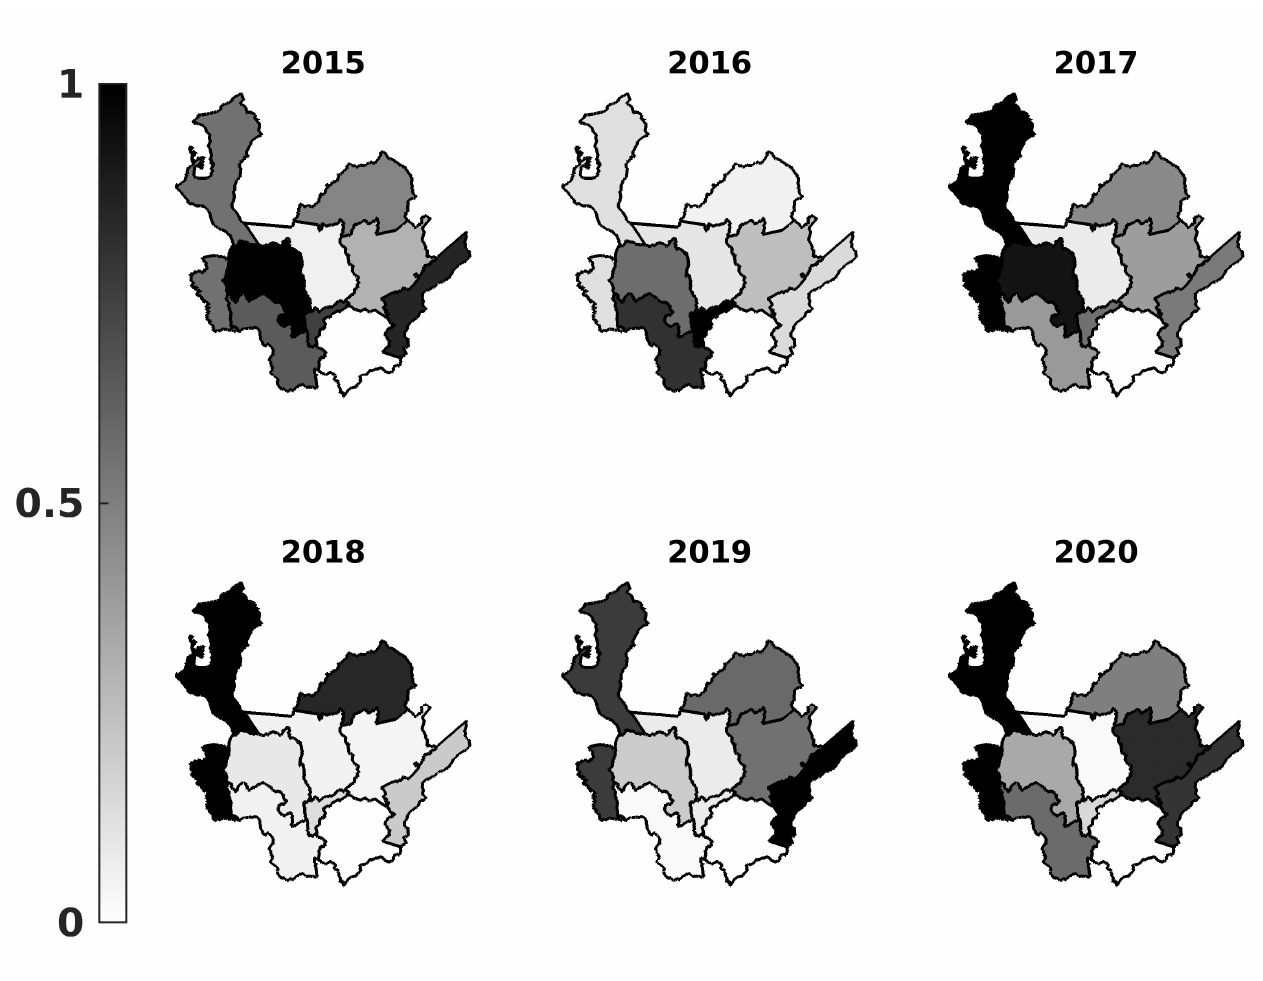
Figure 2. Choropleth map of normalized dengue prevalence in Colombia for cases reported dur- ing